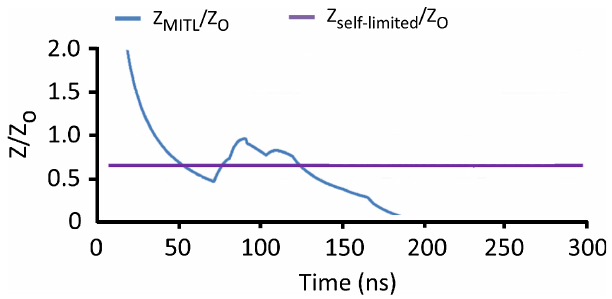
FIG. 12. The operational Z=Z ( Z is the voltage divided by the o ¼ 0 . 69 Ω is the current at the input to the MITLs and Z o equivalent minimum vacuum wave impedance of the four-level MITLs in parallel) for the surrogate load on Z with the standard four-level MITL and PHC. The value for self-limited flow at 2 MV is shown for comparison. With this load, the outer portions of the Z MITLs operate near the self-limited value for the first third of its power